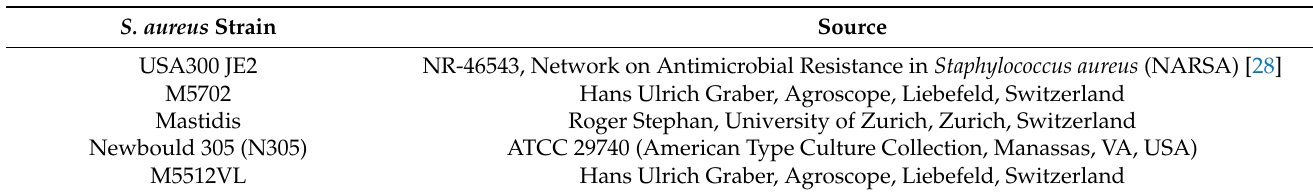
Table 1. Bacterial strains used in the current